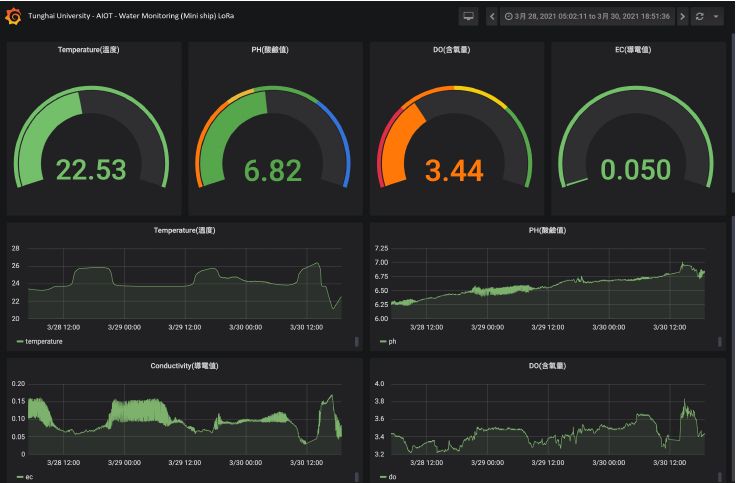
Figure 14. Hourly time axis to observe the variation in logging